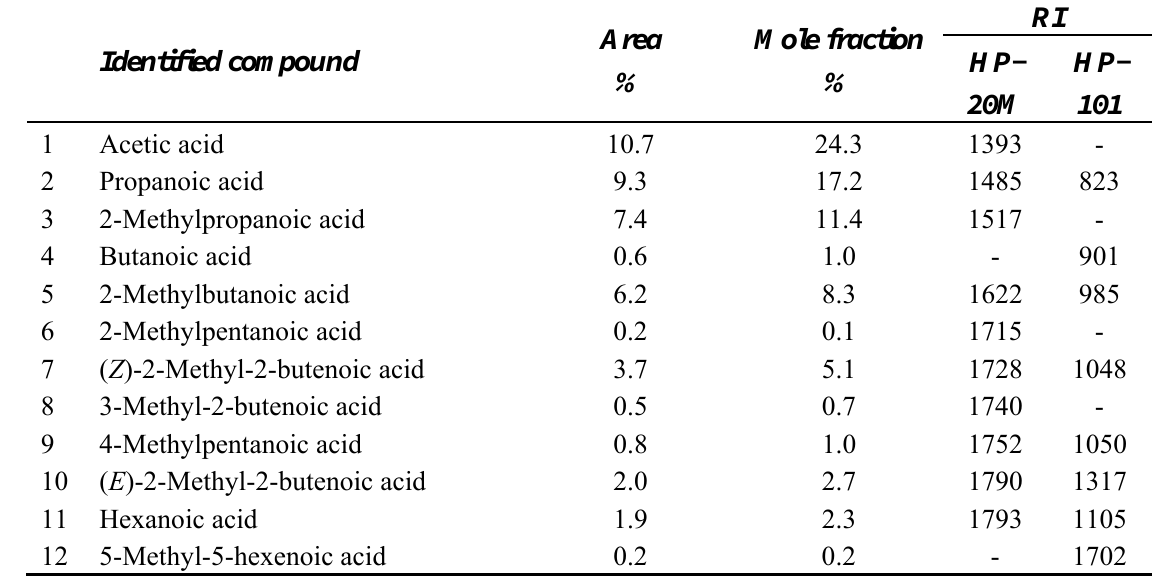
Table 2: Bound acids and phenols of everlasting essential